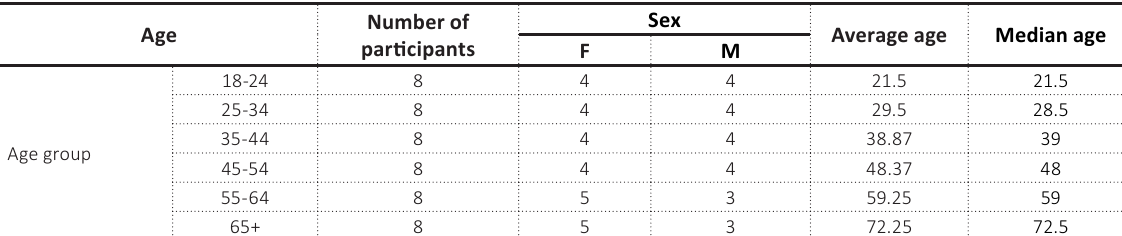
Table 3. Sample characteristic – qualitative study